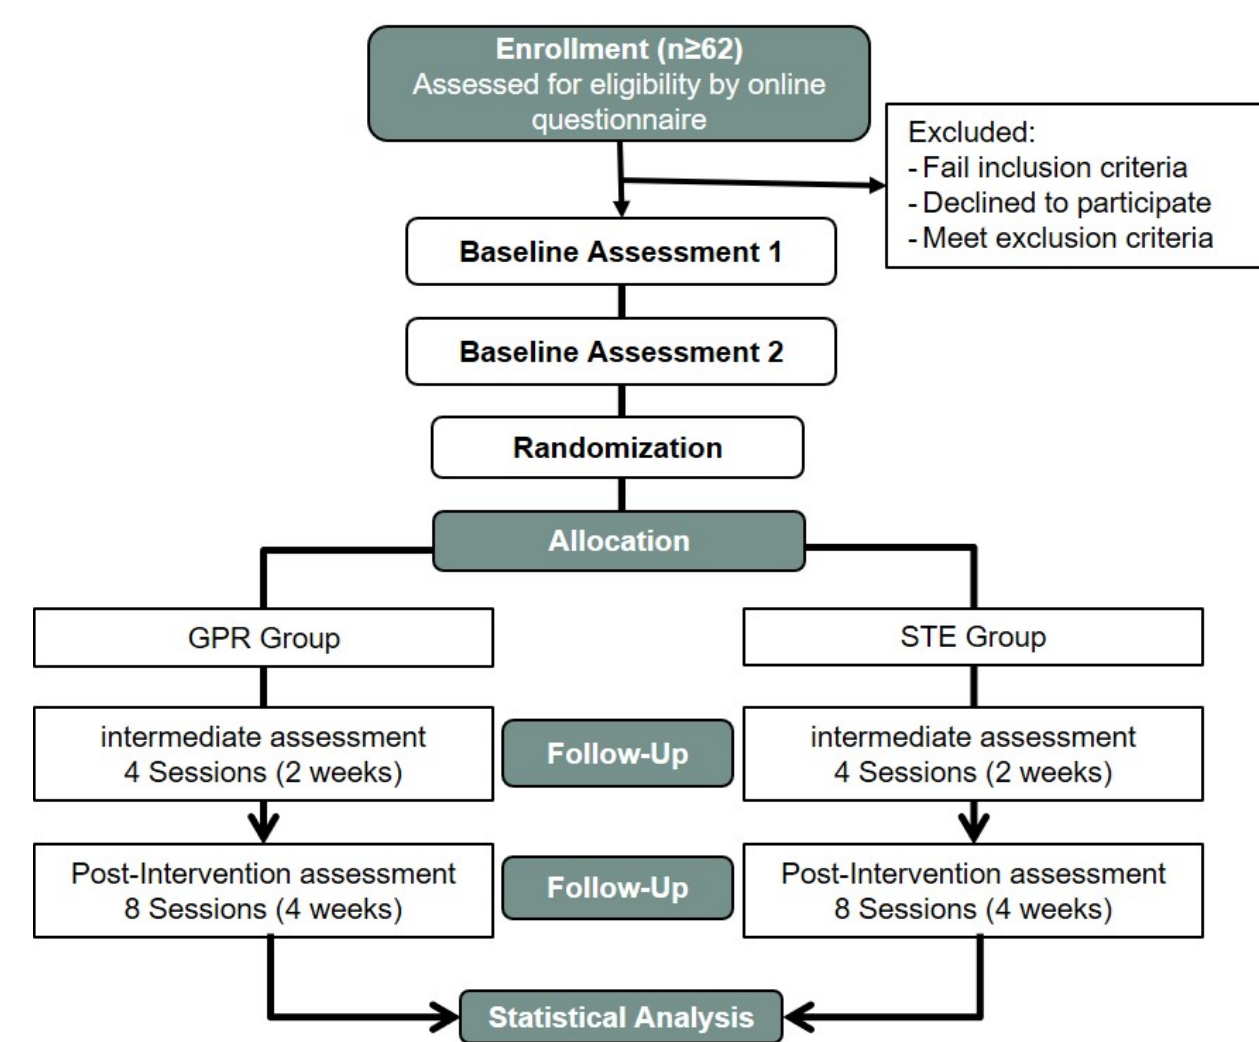
Figure 1. Flow chart of participants in the study. GPR: Global Postural Reeducation; STE: Specific Therapeutic Exercises.